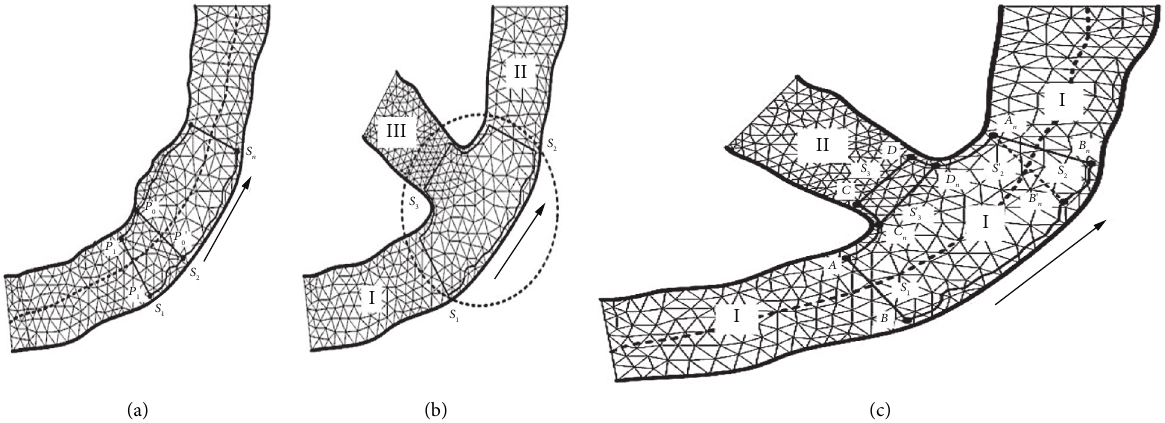
Figure 4: Digital estuary. (a) Remote-sensing image of river boundary. (b) Multiresolution mesh subdivision model for maximum turbidity zone. (c) Dynamic model simulation results of the maximum turbidity zone formed in the estuary of the